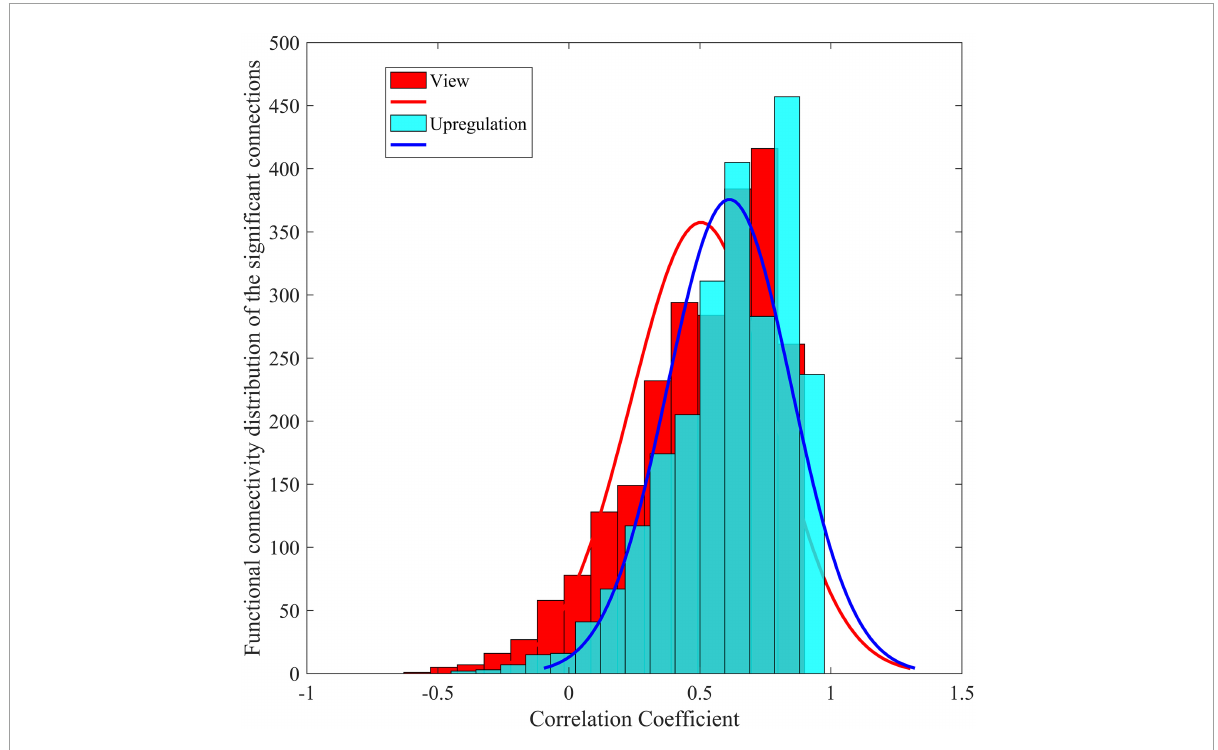
FIGURE6 Functional connectivity distribution of Upregulation and View blocks for significant connections in the experimental group.